Question: Which kind of chart has been used to present this data?
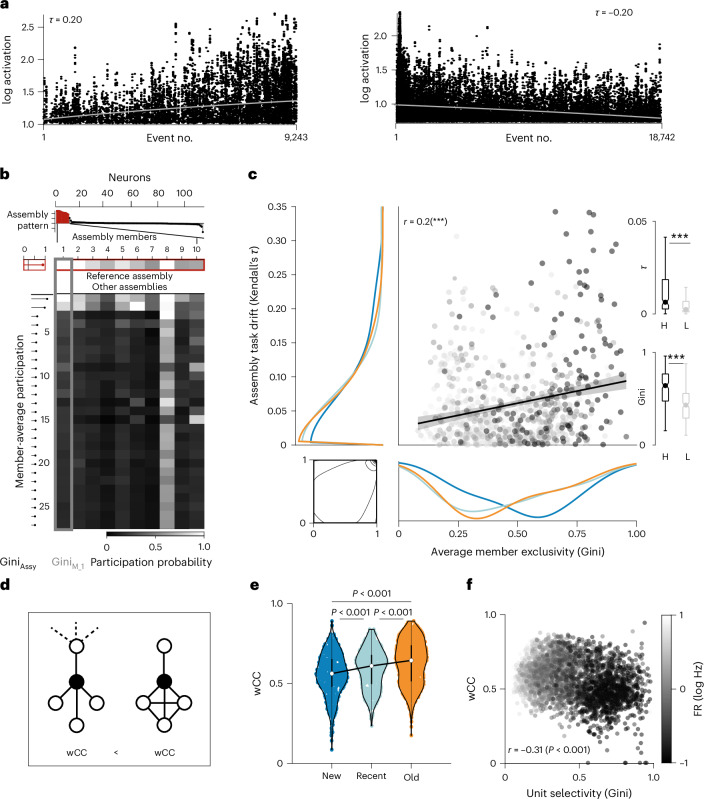
Answer: scatter